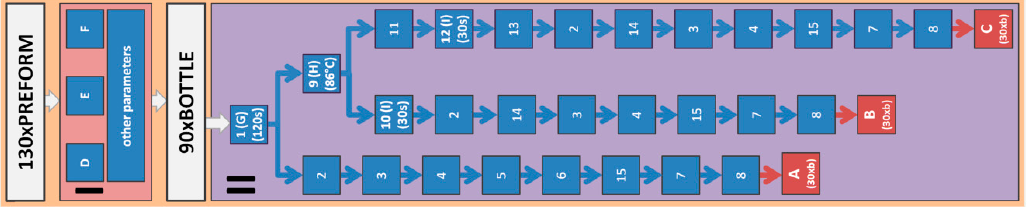
Figure 1. The steps for producing bottles for testing the analysis of assumptions about the normal distribution of measurement errors, and determining the sample size; designations are explained in